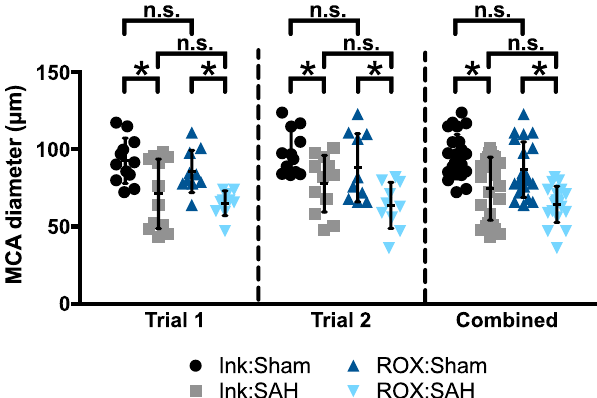
Figure 4. Quantitative comparison between ROX SE perfusion and India ink-gelatin casting techniques. In two separate trials, wild-type mice underwent Sham or SAH surgery followed by either ROX SE perfusion or India ink-gelatin casting. In both trials, both techniques detected significant vasospasm after SAH (p < 0.05 for Ink:Sham vs. Ink:SAH and ROX:Sham vs. ROX:SAH). Although vessel diameters obtained with ROX SE perfusion were slightly smaller, the differences in vessel diameter between the two techniques were non- significant (p > 0.05 for Ink:Sham vs. ROX:Sham and Ink:SAH vs. ROX:SAH). Combined data from the two trials was consistent with results from individual